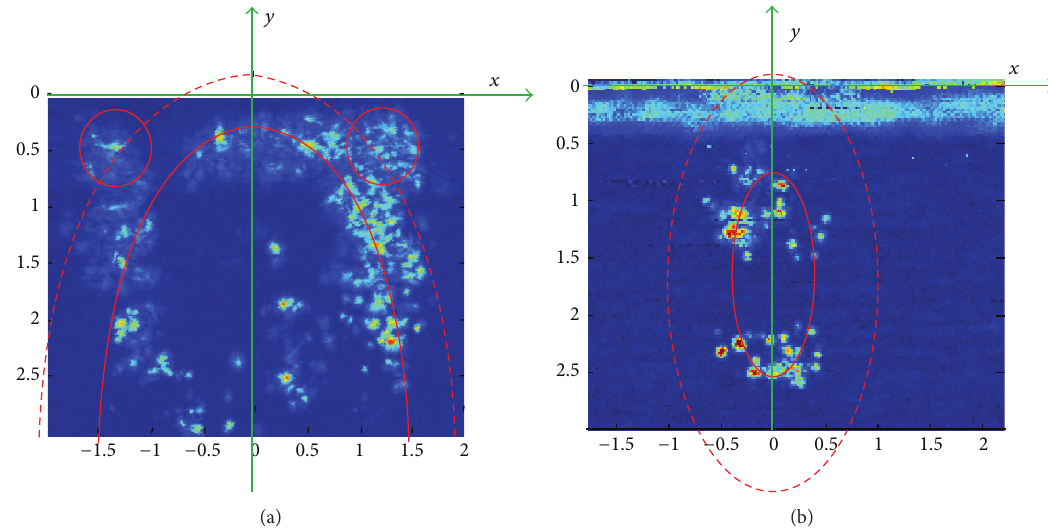
Figure 8: Typical crack images produced by (a) large laser spot and (b) small laser spot. The crack is measured by high-frequency acoustic microscopy. The dashed line shows the laser spot and the solid lines show the region where cracks locate.